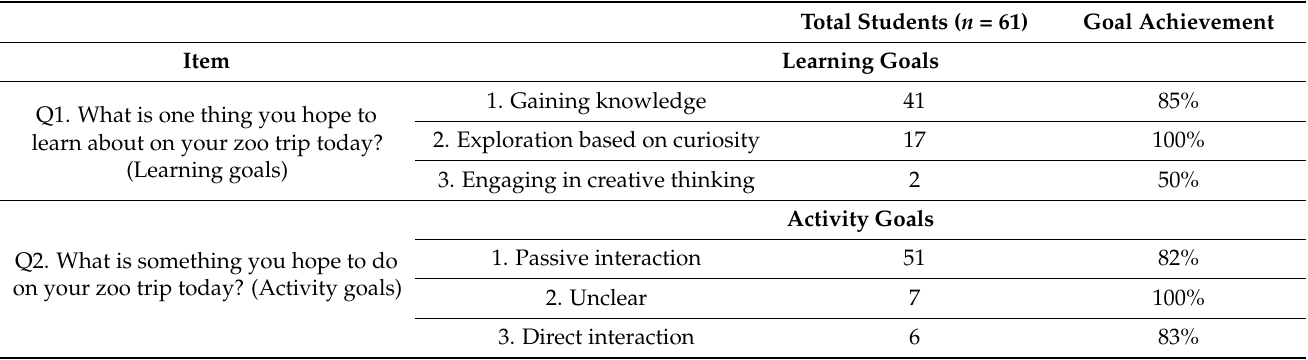
Table 2. Emerging themes for Questions 1 and 2 on the survey, number of students citing each theme, and percent goal achievement for each theme. Learning goals were coded into mutually exclusive themes. Activity goal responses from students could be dual-coded into two or more themes, though this did not occur frequently. Additionally, one student cited that they were “open to learning anything” in their learning goal, which could not be categorized in one of the three learning goals themes. Total Students ( n = 61) Goal Achievement Learning